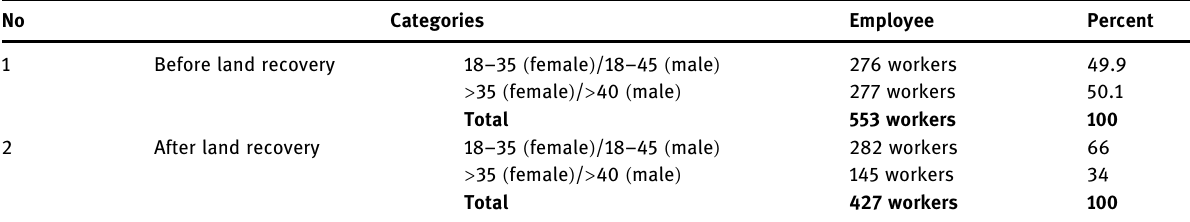
Table 2: Number of Employees with jobs before and after land recovery No